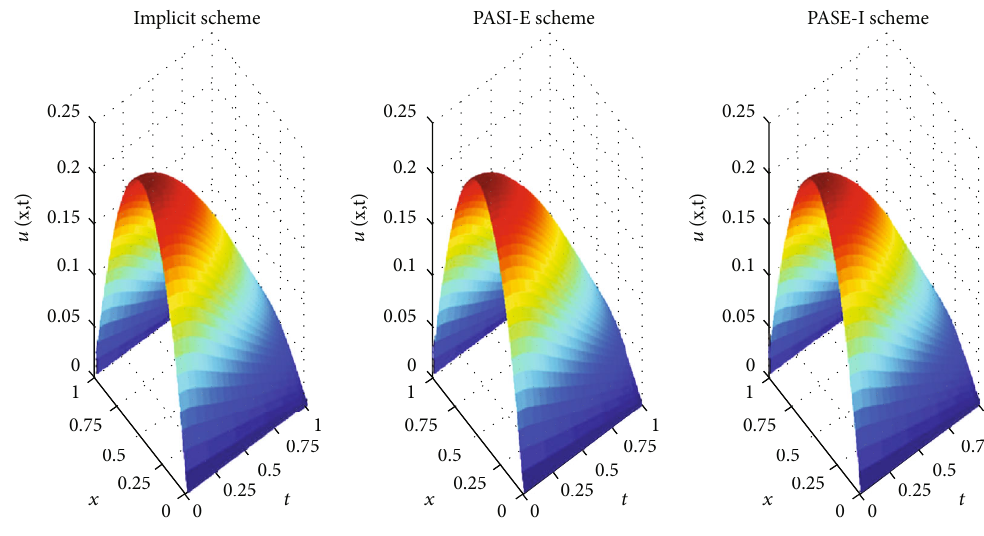
Figure 5: Surfaces of three di ff erence schemes.